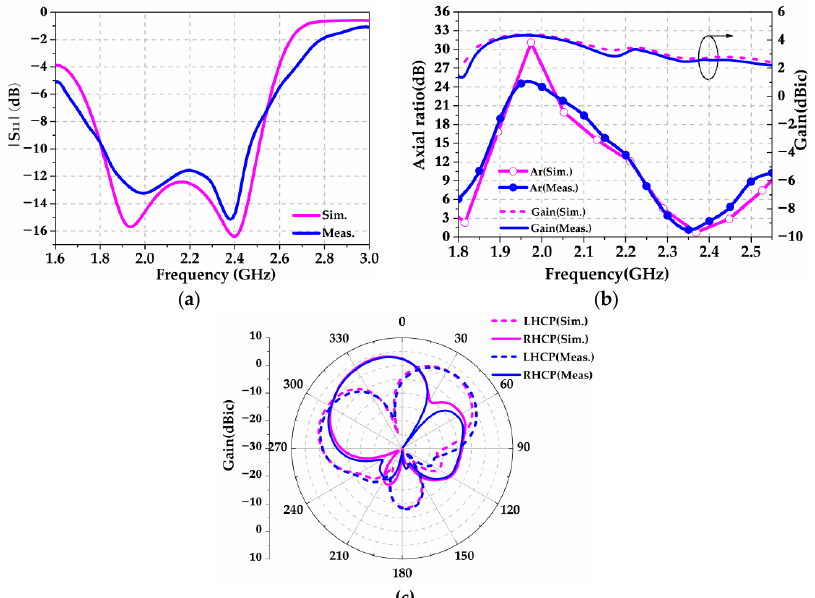
Figure 18. Simulation and measurement results of State-III: ( a ) | S 11 |; ( b ) AR and gain; ( c ) Radiation patterns at 2.4 GHz.